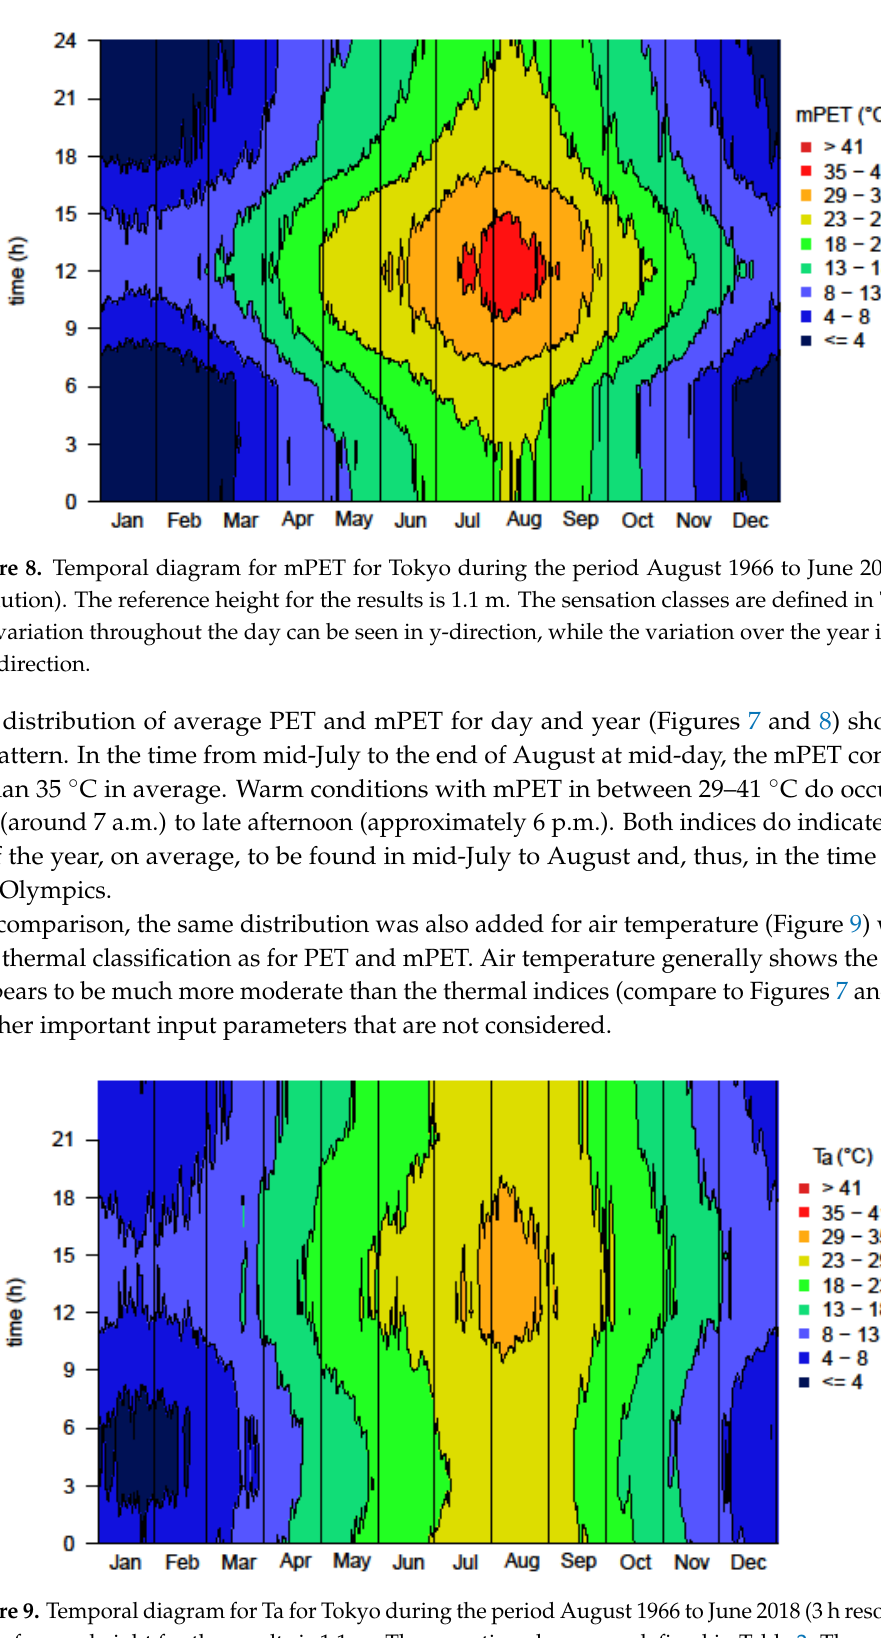
Figure 9. Temporal diagram for Ta for Tokyo during the period August 1966 to June 2018 (3 h